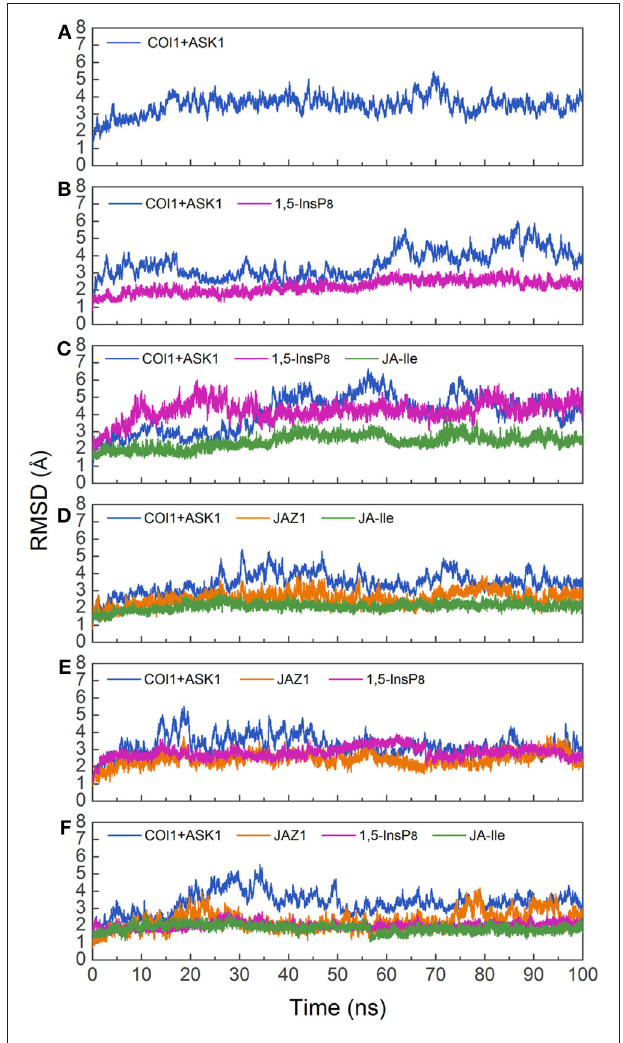
FIGURE 3 | RMSD plots of the complex during molecular dynamics simulation with respect to the crystal structure. (A) system 1, COI1 + ASK1; (B) system 2, COI1 + ASK1 + 1,5-InsP 8 ; (C) system 3, COI1 + ASK1 + 1,5-InsP 8 + JA-Ile; (D) system 4, COI1 + ASK1 + JAZ1 + JA-Ile; (E) system 5, COI1 + ASK1 + JAZ1 + 1, 5-InsP 8 ; (F) system 6, COI1 + ASK1 + JAZ1 + 1,5-InsP 8 +